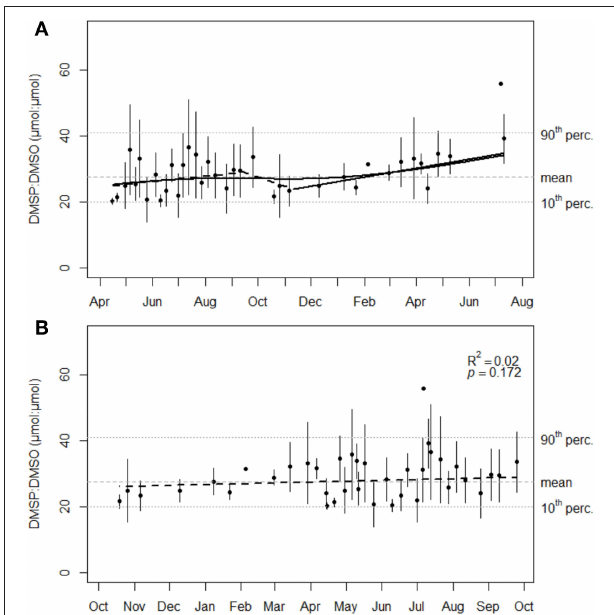
FIGURE 6 | (A) Evolution of the DMSP:DMSO ratio ( µ mol: µ mol) in P. oceanica third leaf at 10m depth (mean ± sd, n = 3 except February 5, 2016 and July 7, 2016, n = 2). The dashed (non-significant slope at p = 0.01) and solid (significant slope at p = 0.01) segments of the broken black line and the solid black line are predictions from segmented linear regression and cross-validated smoothing cubic spline analyses, respectively, for the leaf ratio values between 10th and 90th percentiles. (B) DMSP:DMSO ratio values ( µ mol: µ mol) bounded to October, regardless of the year. The dashed black line represent the non-significant linear trend of leaf ratio values over the year for data between 10th and 90th percentiles. Model R 2 and p -value are shown on the graph. Tenth and ninetieth percentiles (horizontal dotted gray lines) and the mean ratio value (horizontal dashed gray line) of the interpercentile range are reported on both